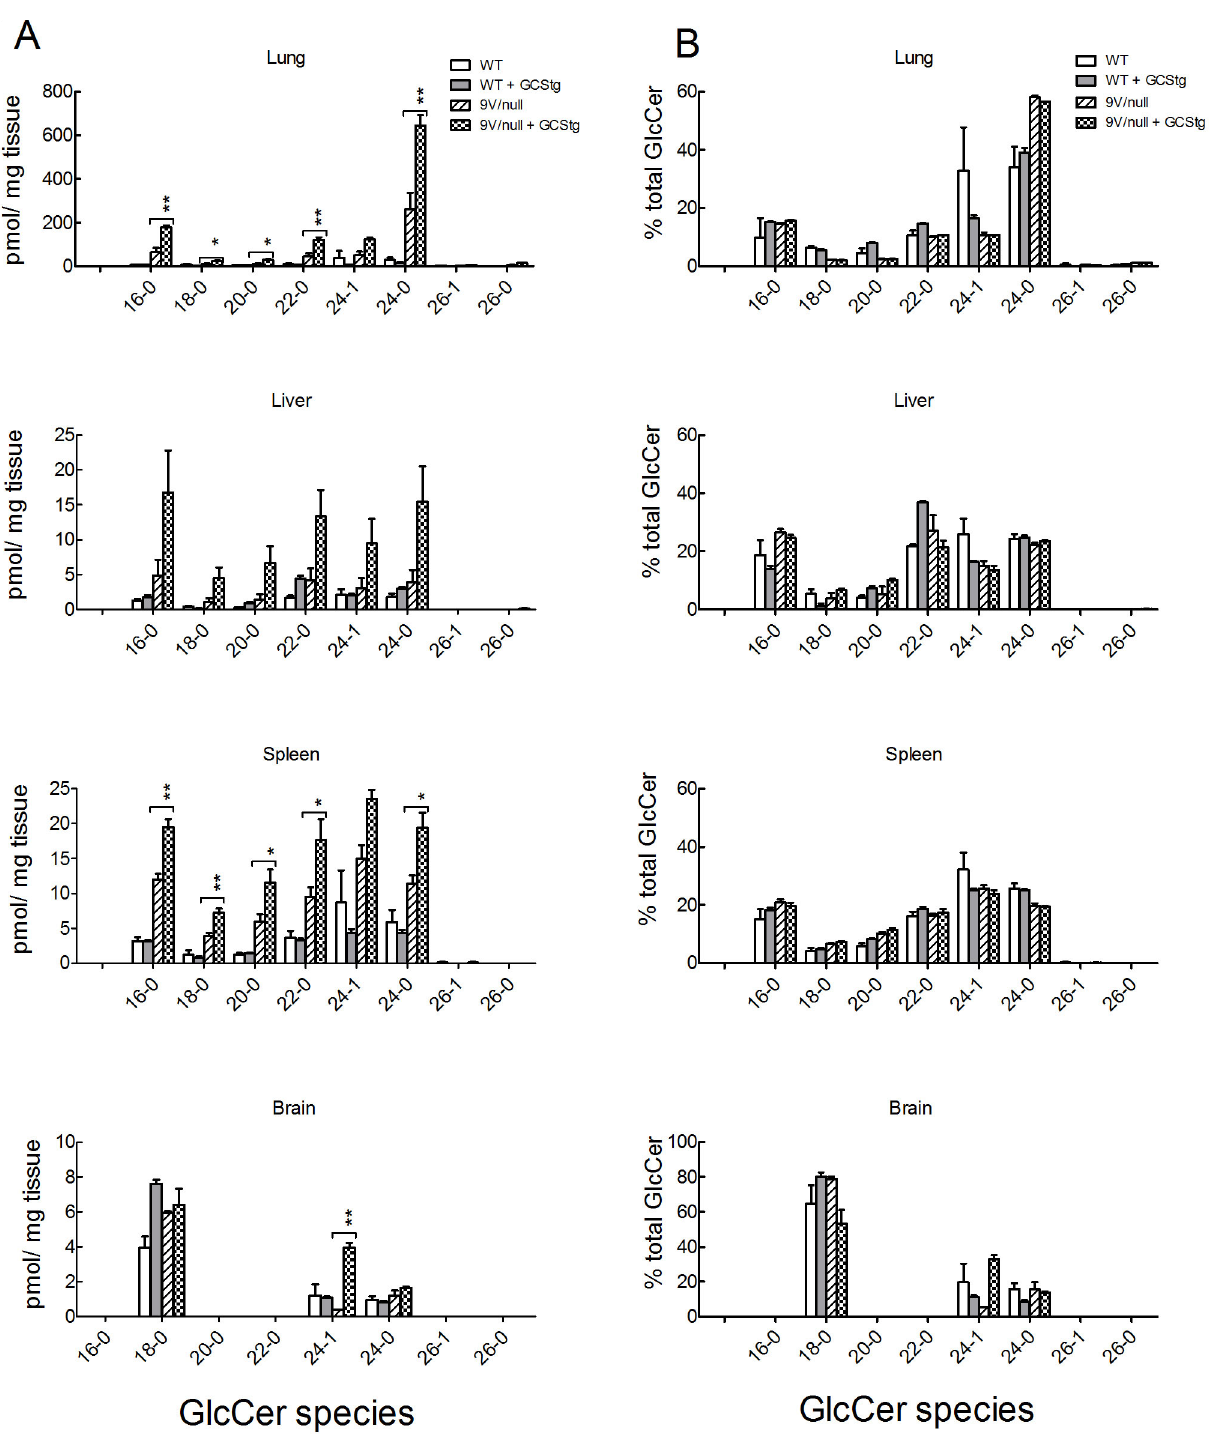
Fig. 4. GlcCer species in visceral tissues of 9V/null/GCStg mice. (A) Tissue GlcCer species in the lungs, livers, spleens and brains from 9-wk of WT, WT + GCStg, 9V/null and 9V/null + GCStg mice were quantitated by LC/MS analysis. The concentration of each GlcCer species was plotted as pmol/mg tissue (Y-axis) in bar graph vs. GlcCer species in X-axis. *, p , 0.05 and **, p , 0.001 were from one-way ANOVA analysis by comparison of 9V/null and 9V/ null + GCStg. (B) Tissue GlcCer species patterns. Each GlcCer species was presented as the percentage of total amount of GlcCer species (Y-axis) in